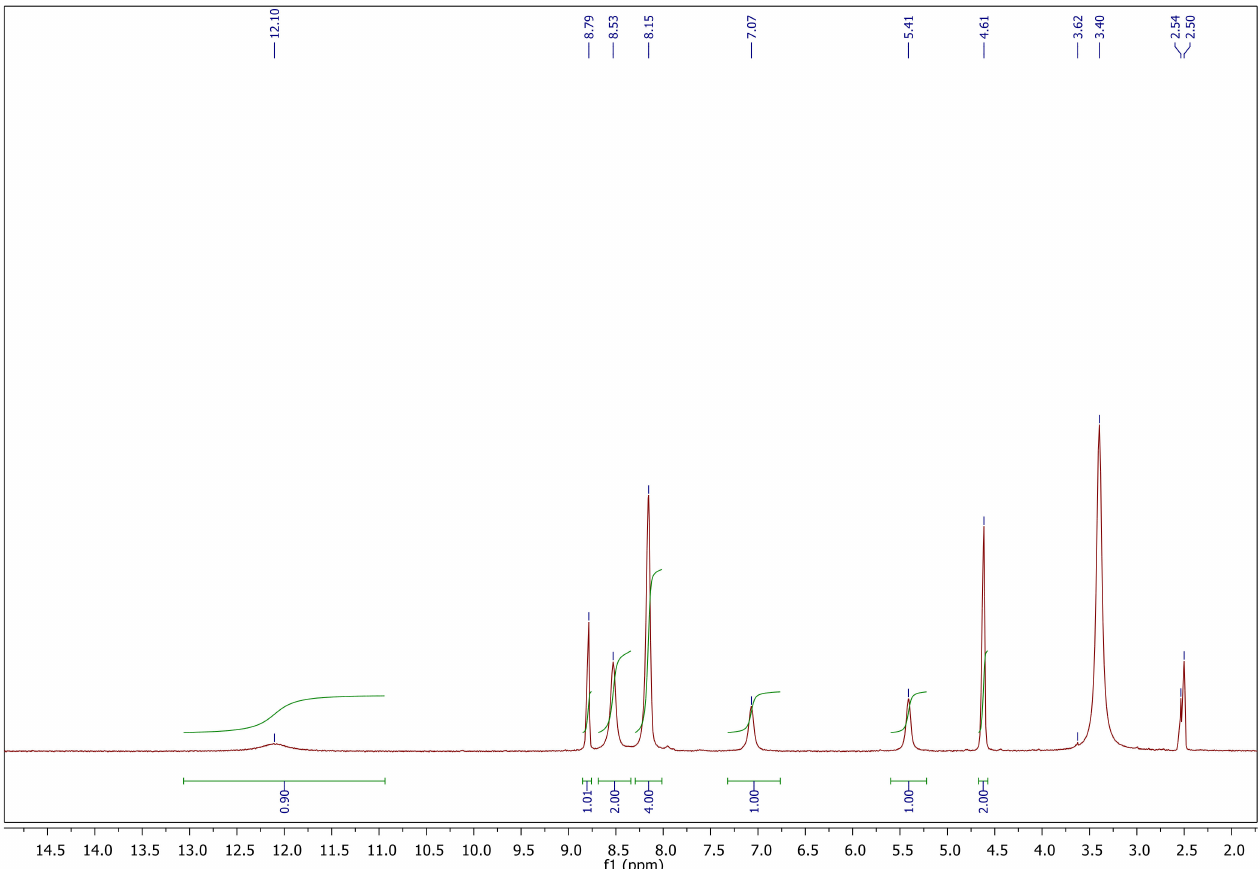
Figure 2. 1 H NMR Spectrum of the 1,2,3-triazole-sulfoamide molecular conjugates 3a